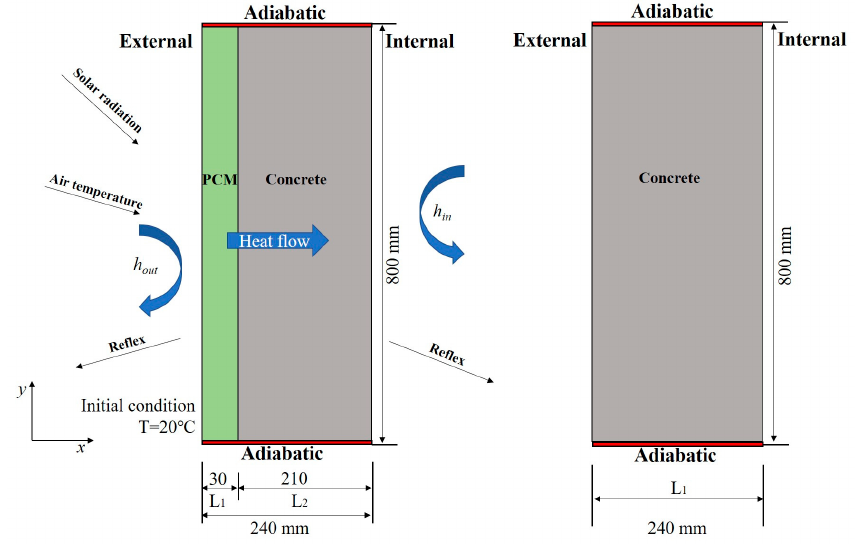
Figure 5. The experimental platform of the SSPCM granary wall.